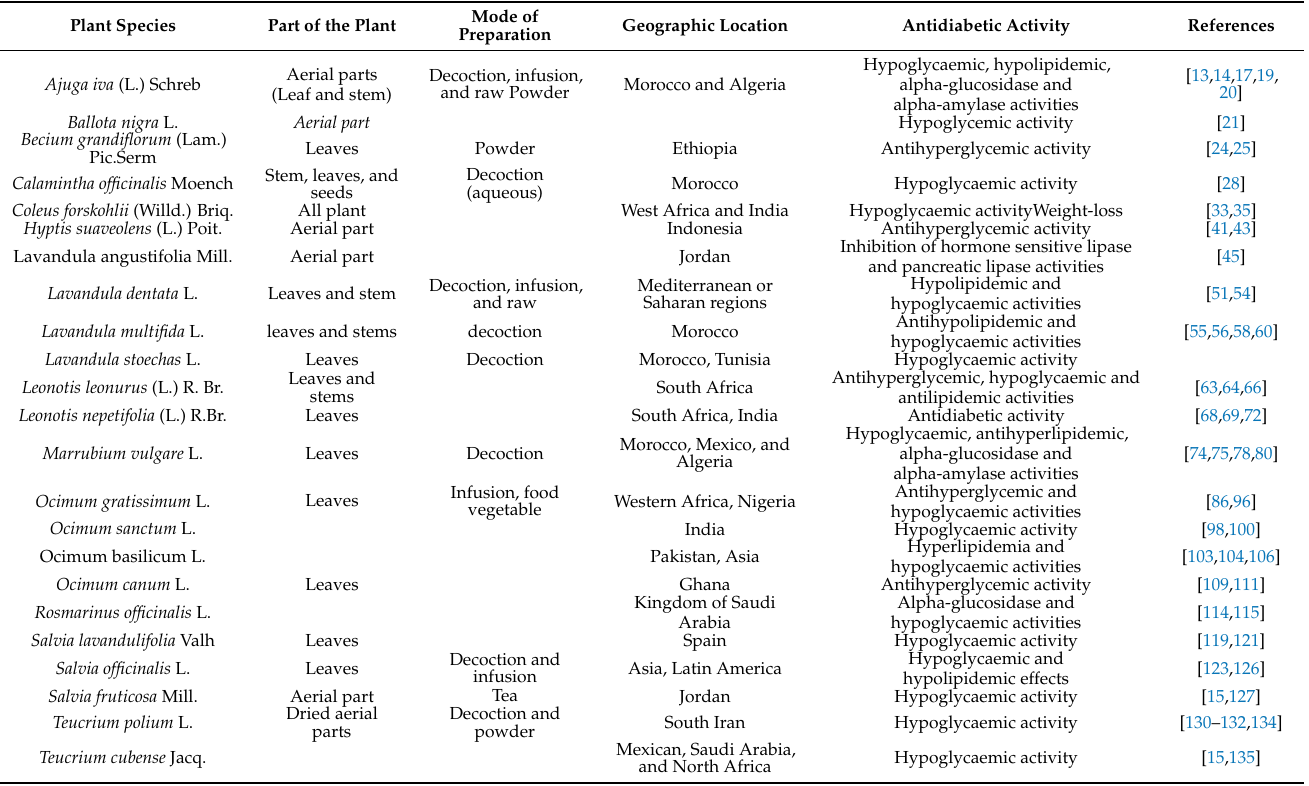
Table 1. List of plants used traditionally for